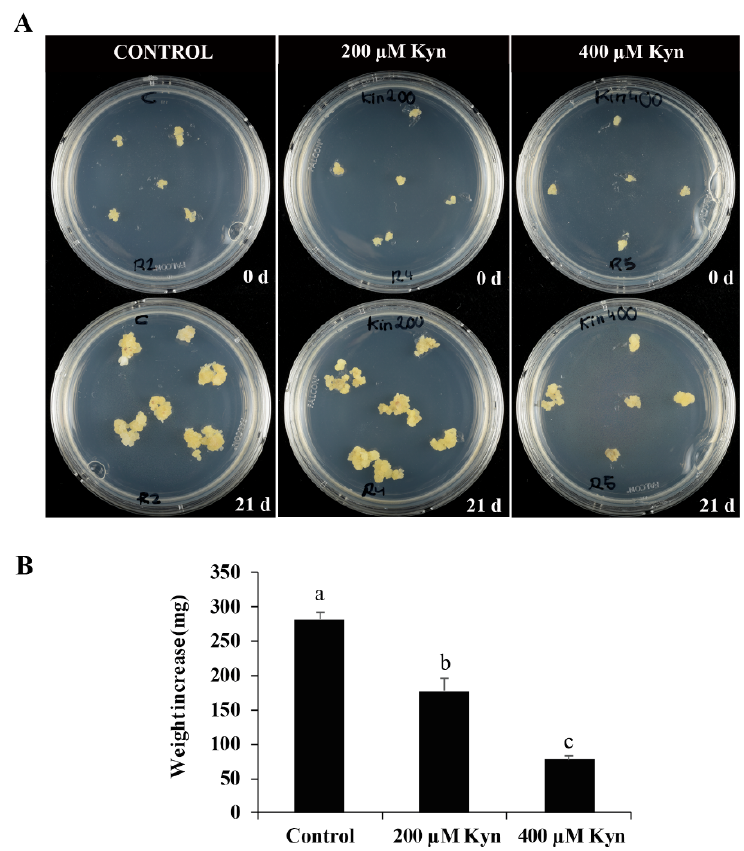
Figure 5. Effect of the inhibitor of auxin biosynthesis kynurenine on SE. ( A ) SE cultures at the beginning of the treatment, at 0 days, and after 21 days of treatment. Left pictures: untreated cultures; central pictures: 200 µ M kynurenine treatment; right pictures: 400 µ M kynurenine treatment. ( B ) Quantification of the proliferation of proembryogenic masses in control cultures and cultures treated with kynurenine. Columns represent mean values of relative fresh weight after 21 d of treatment; bars represent the standard error of the mean. Different letters in the columns indicate significant differences according to ANOVA and Tukey’s test at p ≤ 0.05.